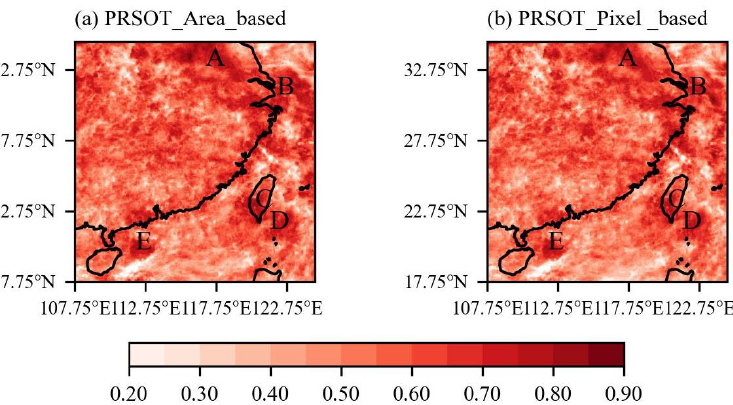
Figure 10. Spatial distribution of correlation coefficients for PRSOT_Area_based ( a ) and PRSOT_Pixel_based model ( b ) in testing dataset during August 2018. The letters A, B, C, D, and E represent the major subregions with correlation coefficients greater than